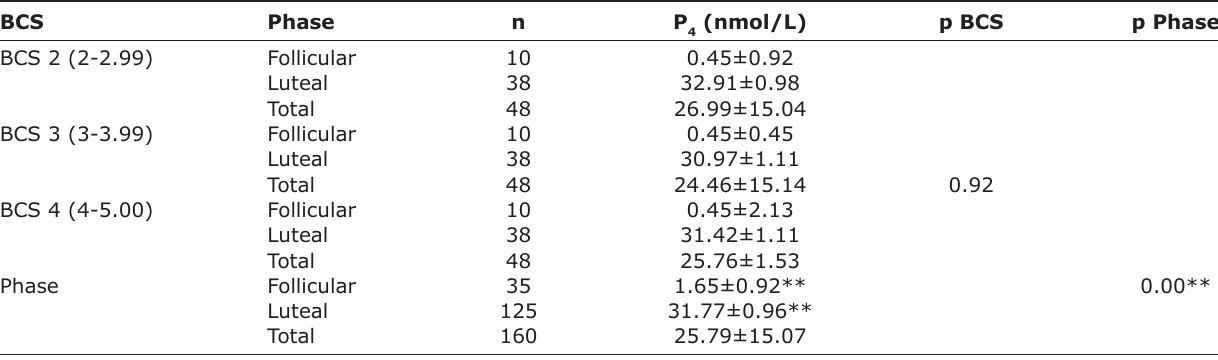
Table-7: Progesterone levels of Saanen goats in each body condition score during the phases of estrous cycle